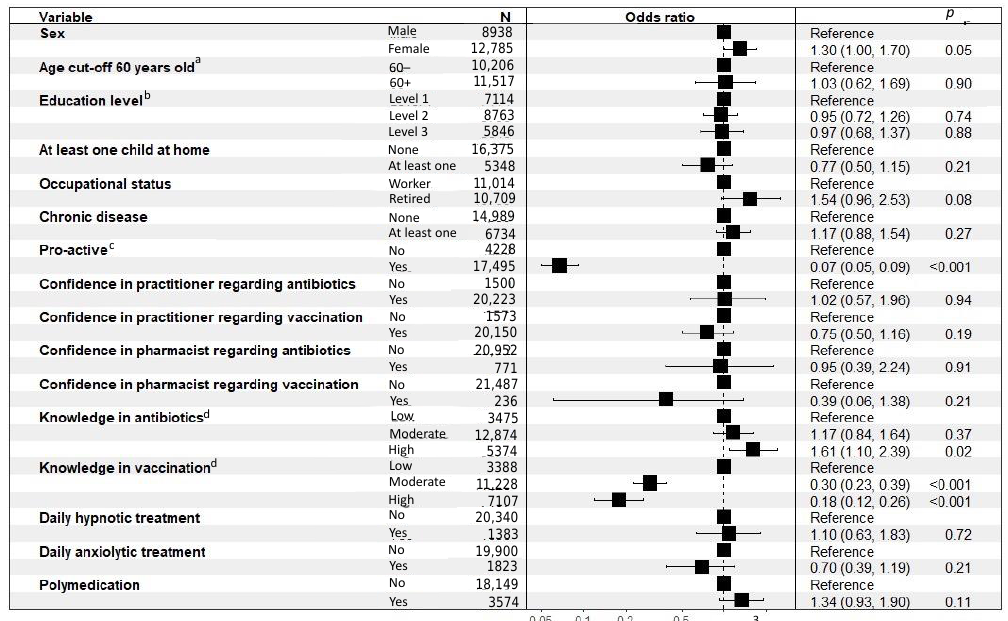
Figure 6. Binary logistic regressions performed to evaluate the determinants of vaccinophobia. a The age cut-off was determined at 60 years old to have homogenous age range; b Level 1: Level of edu- cation below “Baccalaureate” (French high schoo l diploma) degree, Level 2: Level of education greater than or equal to “Baccalaureate” degree and less than or equal to “Baccalaureate” degree plus 2 years, Level 3: Level of study higher than “Baccalaureate” degree plus 2 years; c Proactive: ((asks physician for antibiotics) OR (if taking meds, has already discussed it with physician/phar-